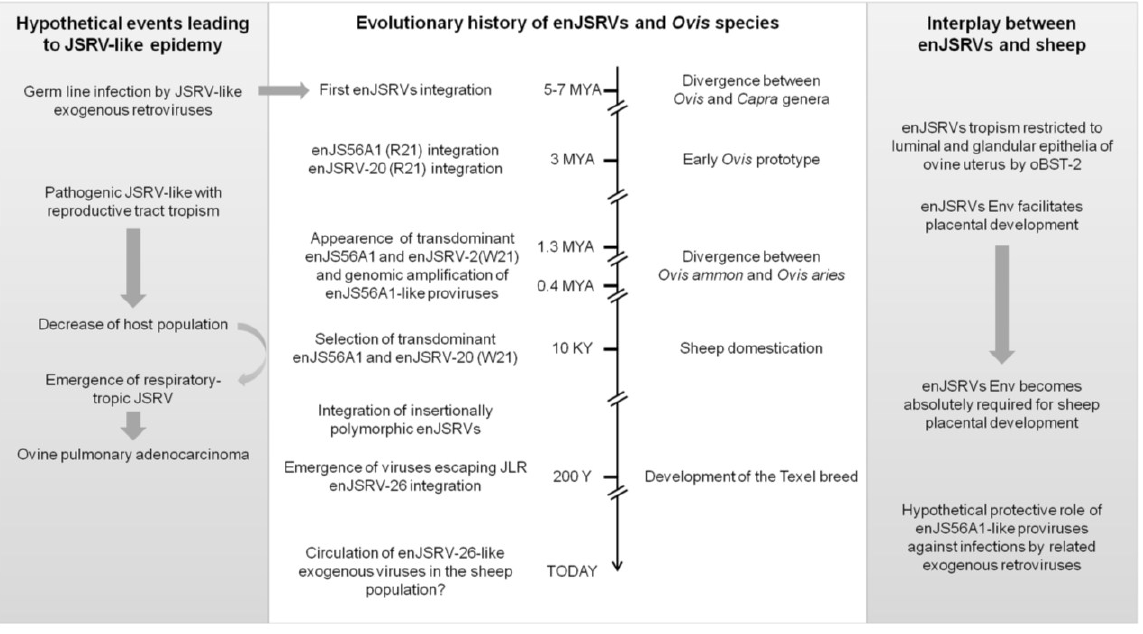
Figure 3. Hypothetical adaptation and counter-adaptation events between enJSRVs, JSRV and their host during evolution. See text for more details. enJSRV, endogenous Jaagsiekte sheep retrovirus; JLR, JSRV late restriction; JSRV, Jaagsiekte sheep retrovirus; oBST-2, ovine bone marrow stromal cell antigen 2; R21, arginine residue at position 21 of enJS56A1/enJSRV-20 Gag; W21, tryptophan residue at position 21 of enJS56A1/enJSRV-20 Gag (Figure modified from Varela et al. 2009)